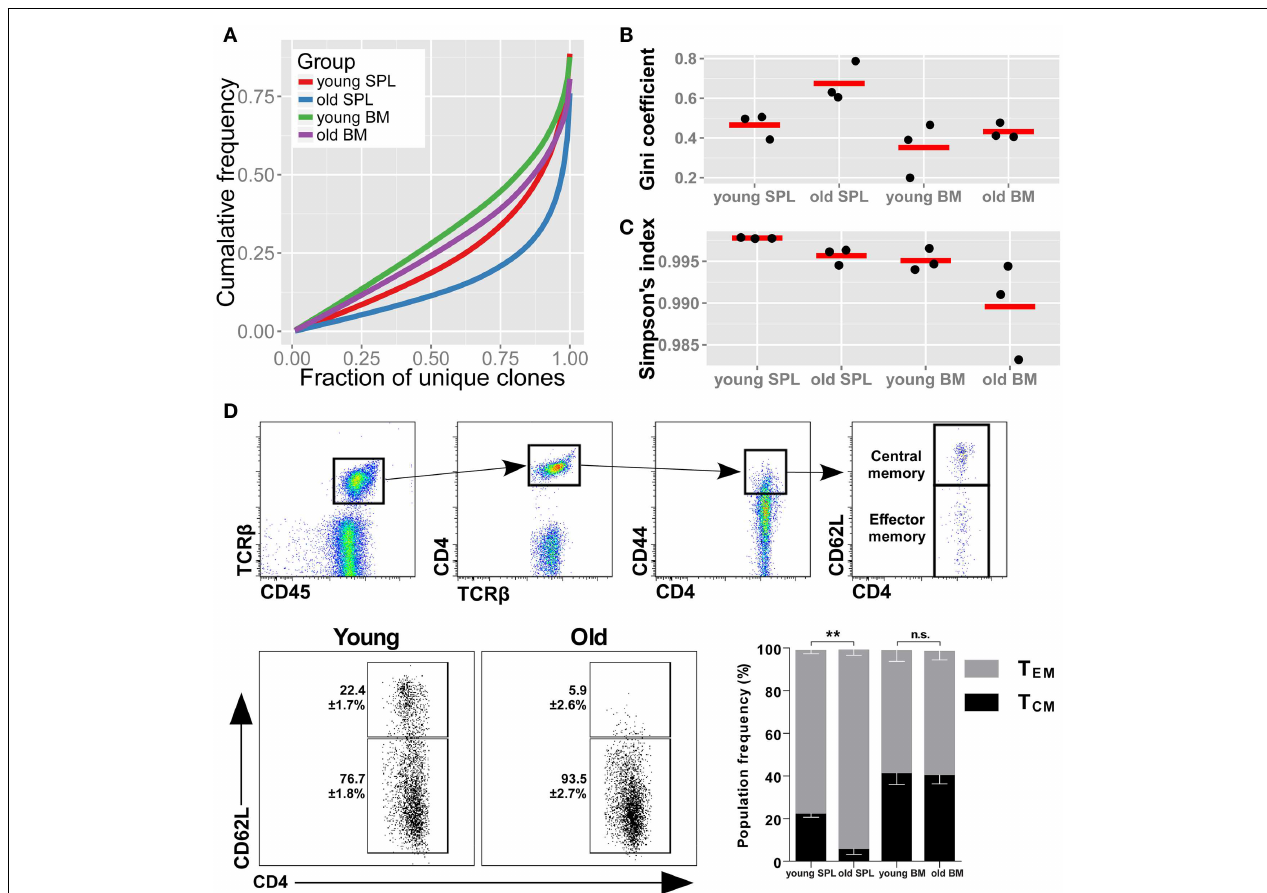
index calculated for each mouse (dots). Horizontal lines represent the mean for each group.The old SPL group has a significantly lower diversity than the young SPL group. (D) Phenotypic changes of CD4 + memoryT cells in aging.Top panels show flow cytometric gating strategy. Old spleen samples have significantly higher percentage of effector memoryT cells compared to young spleen samples (bottom panels and bar graph). BM samples have similar central/effector memory ratios across age groups (mean ± SE of each group ( n = 4–5 per group; ** P < 0.01; Student’s t